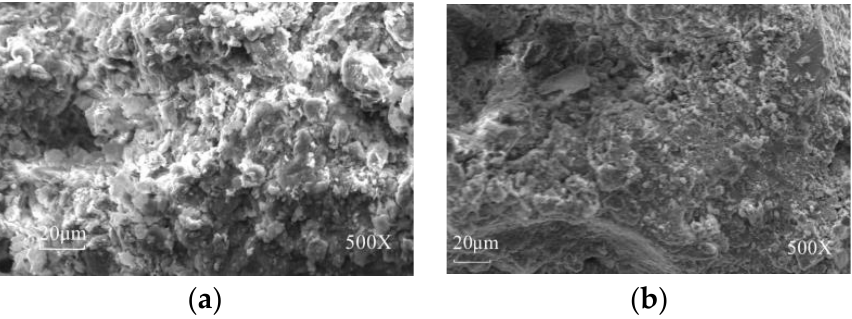
Figure 8. Change in soil microstructure before and after porous clay plate test. ( a ) Structure of soil sample before test; ( b ) structure of soil sample after test.